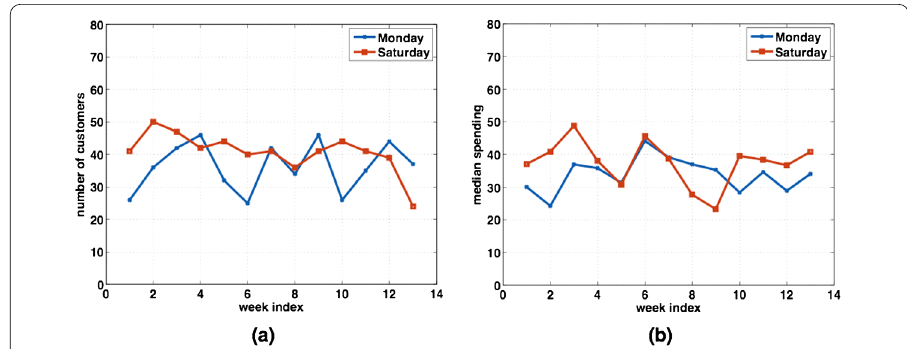
Figure 2 Time series of the two behavioral indexes in a given neighborhood on Mondays and Saturdays: ( a ) number of customers; ( b ) median spending